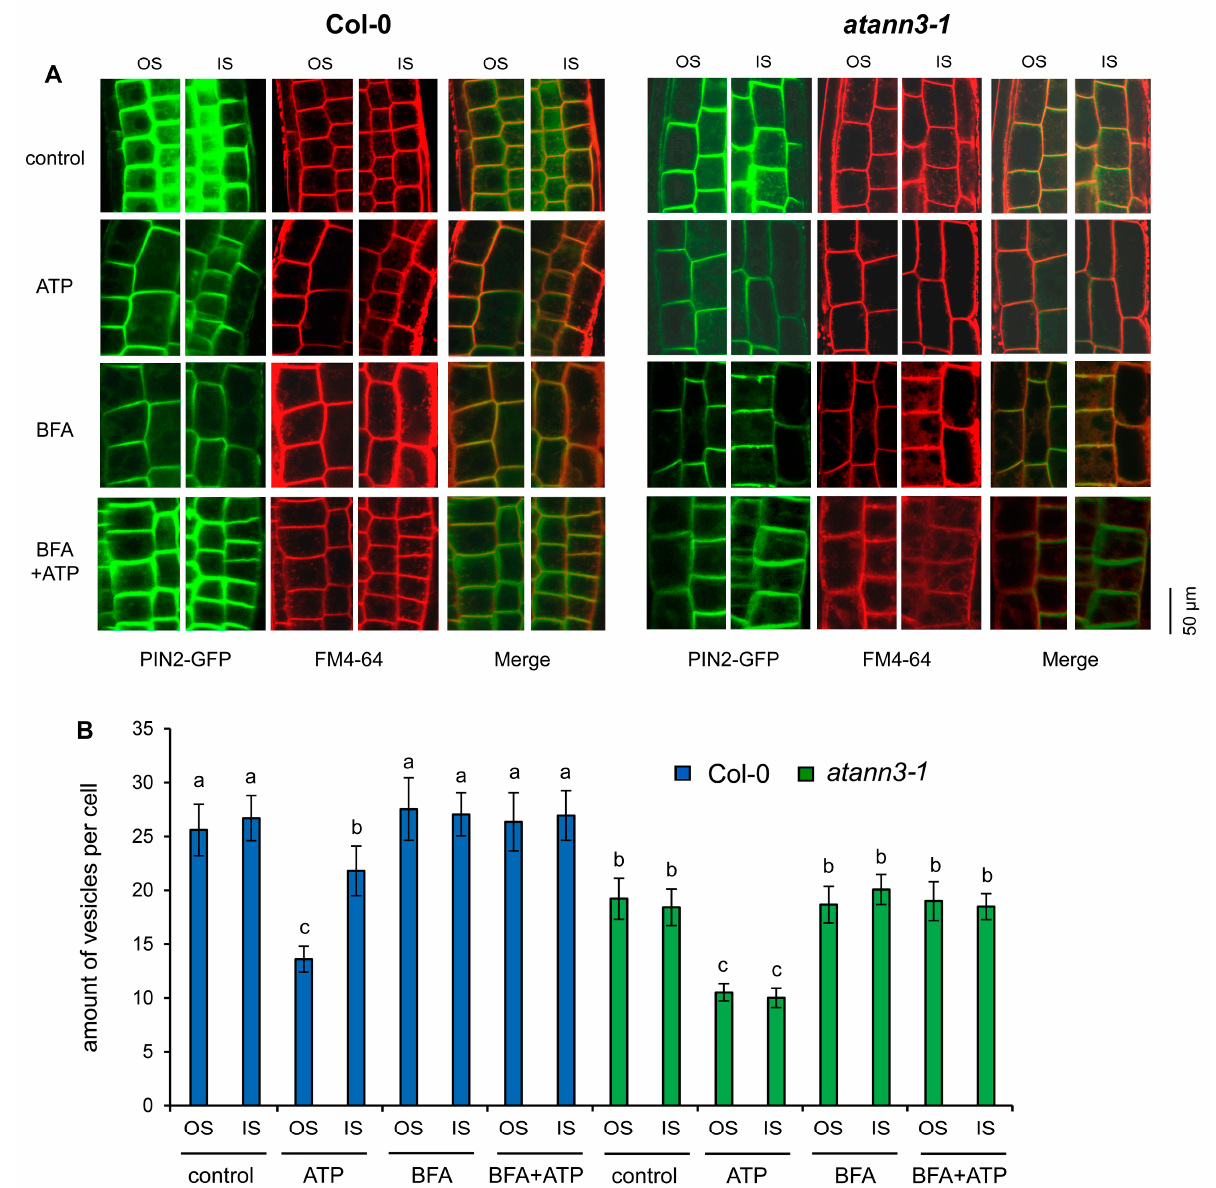
Figure 6. AtANN3 is involved in the eATP-regulated PIN2-GFP-containing vesicle abundance in root-tip cells. ( A ) Images of the cells at the inner side (IS) and the outer side (OS) of the bending area and ( B ) the number of vesicles in root cells. In each experiment, at least 40 cells in 5–6 seedlings were measured, and data from three replicates were combined to obtain mean ± SD and statistically analyzed. The same letter on the top of the columns indicates that the means of different groups were not significantly different based on Duncan’s multiple range test ( p < 0.05).